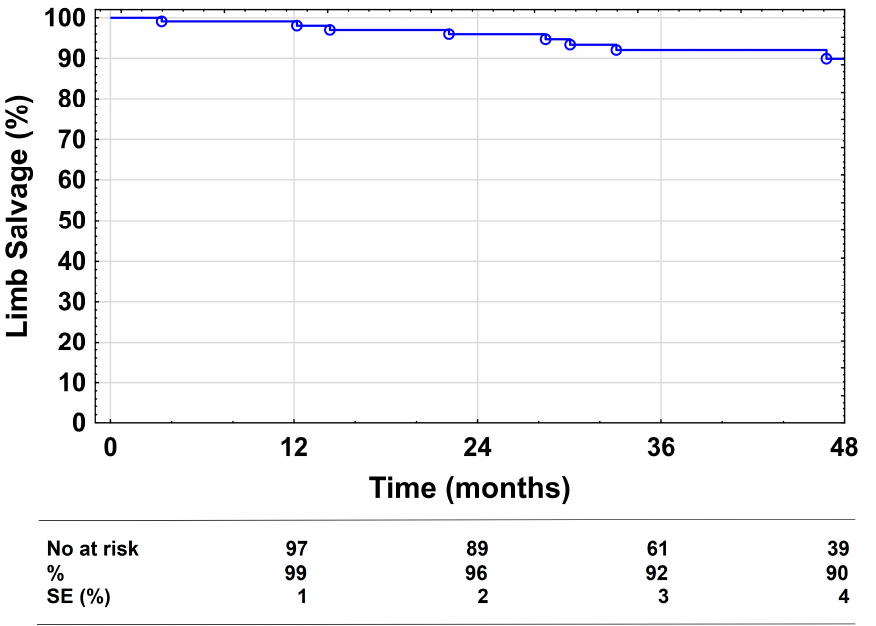
Figure 4. Limb salvage. Kaplan–Meier estimates presenting limb salvage during the 48-month follow-up, including all cases. SE = standard error.